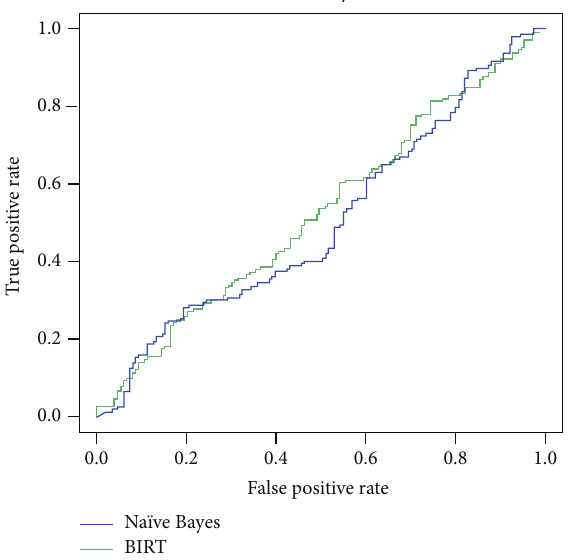
Figure 6: ROC for BIRT and na¨ıve Bayes classifier.